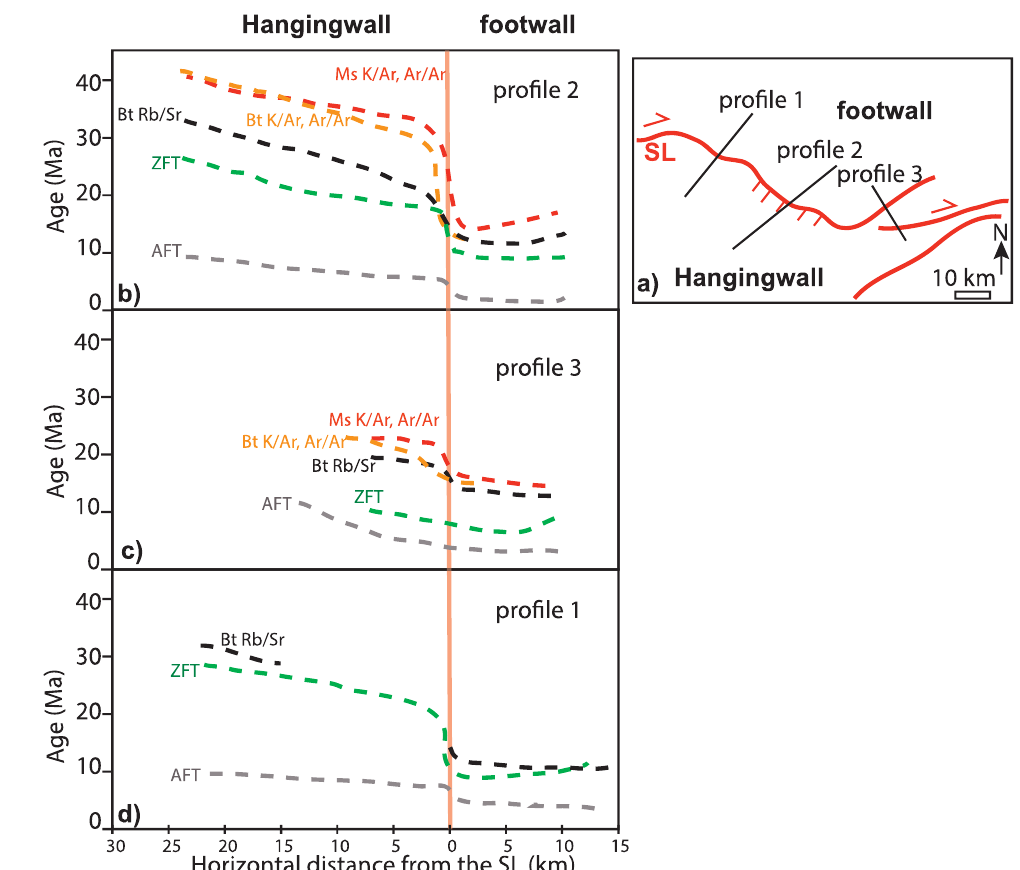
Figure 2. Compilation of a variety of thermochronological ages on both sides of the Simplon normal fault (see location on Figure 1; from [15]). Cooling age patterns across the Simplon Fault Zone. ( a ) Location of three age–distance sections. ( b ) Age–distance section from the central region (central part of Simplon Line or SL. ( c ) Age–distance section from the SE region. ( d ) Age–distance section from the NW region.